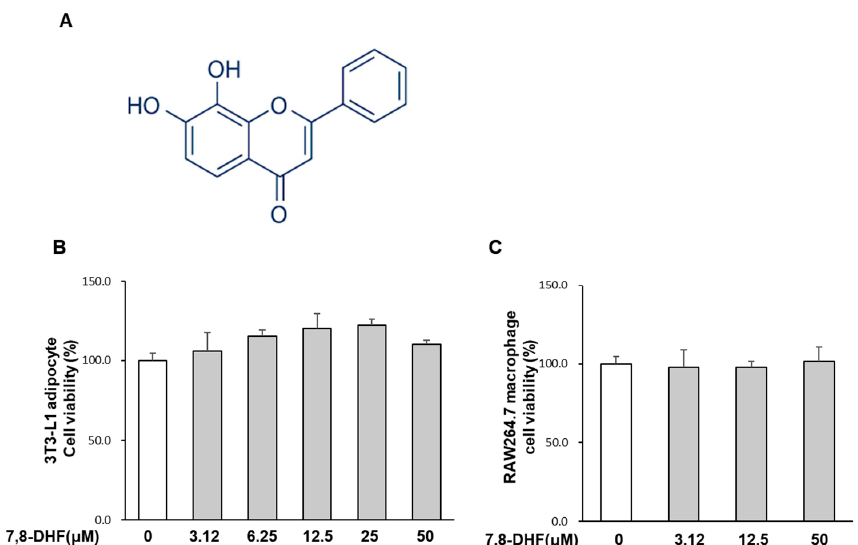
Figure 1. Effect of 7,8-DHF on the viability of 3T3-L1 cells and RAW 264.7 macrophages. ( A ) Structure of 7,8-DHF. ( B , C ) Cell viability was assessed using the MTS assay after 24 h exposure to various concentrations of 7,8-DHF (3.12, 12.5, and 50 µ M). Results are expressed as a percentage relative to the untreated control cells. Values are mean ± standard deviation (SD) ( n = 6) and representative